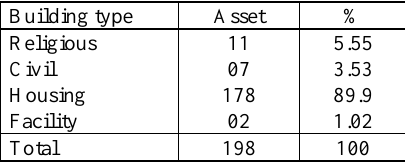
Table 1. Heritage value buildings